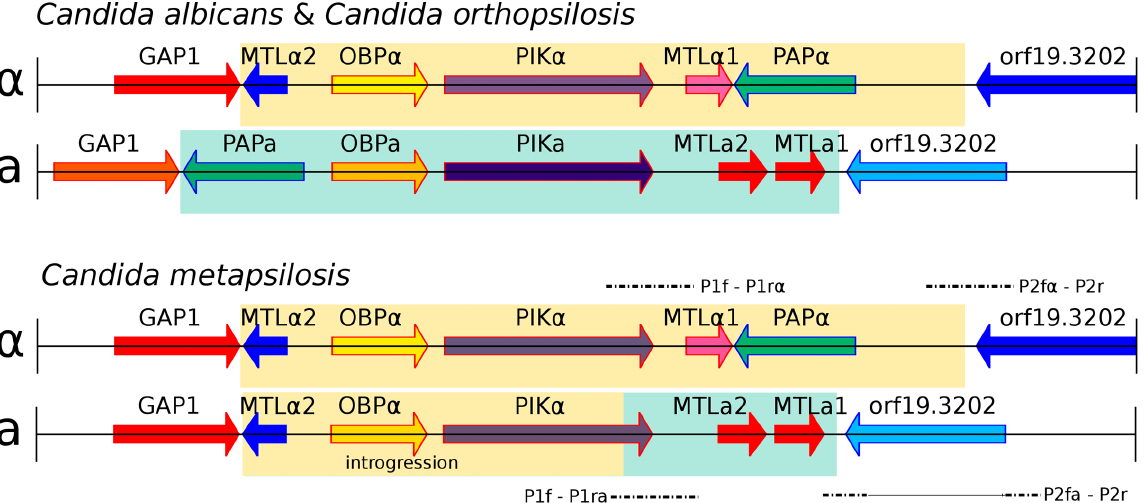
Fig 3. Genomic organisation of mating type locus (MTL) idiomorphs, MTLa (yellow) and MTL α (green), in three Candida species. C . albicans and C . orthopsilosis encode both MTL idiomorphs (A). C . metapsilosis encodes complete MTL α and partial MTLa (B). MTLa introgression in C . metapsilosis was confirmed with PCR and Sanger sequencing. Alignments of Sanger products are denoted with dashed lines. P1f-P1r α and P2f α -P2r align to MTL α . In contrast, P1f-P1ra and P2fa-P2r align to parts of both MTL α and MTLa. The long, horizontal line in P2fa-P2r represents a partial alignment of this Sanger sequence to MTL α and partial MTLa